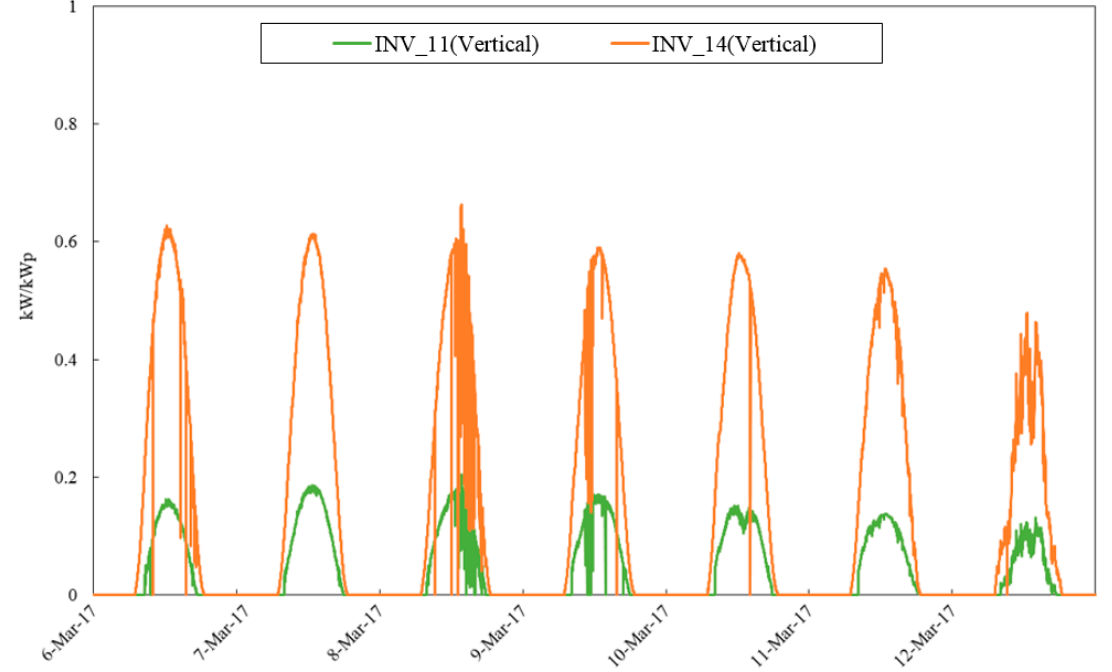
Figure 18. Comparison of energy production per kWp between vertical BIPV systems (Inv-11, Inv- 14).